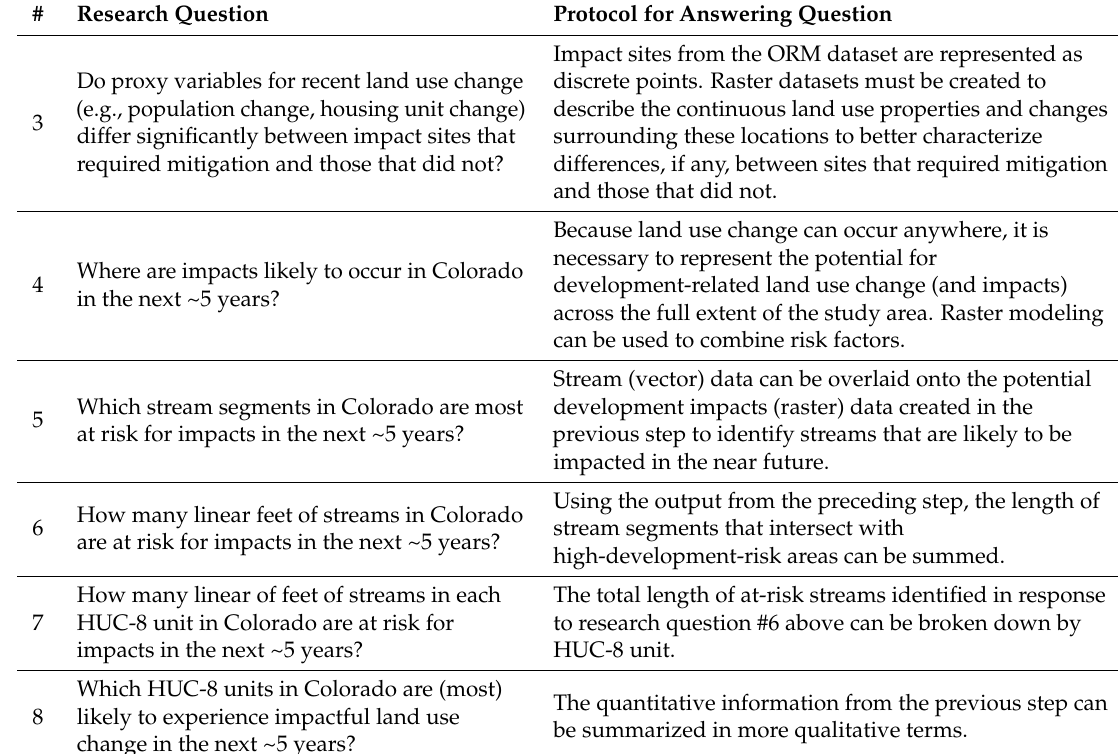
Table A1. Approach to answering the remaining research